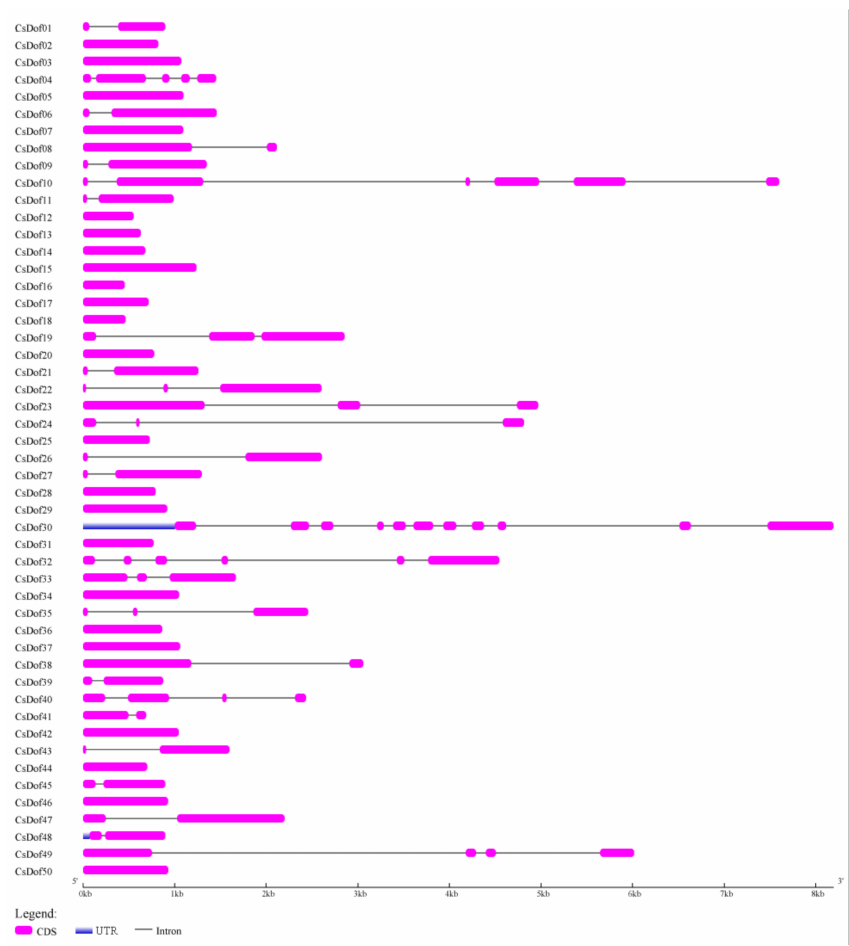
Figure 3. Gene structure of 50 CsDof genes in C. songorica . CDS, UTR, and introns are indicated by purple, blue, and black,